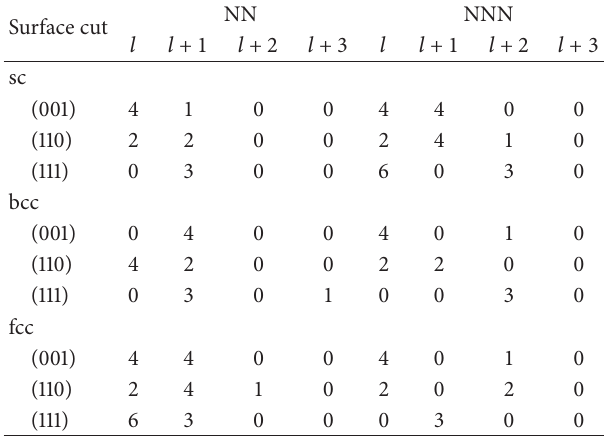
Table 1: The numbers of nearest neighbors (NN) and next nearest (NNN) neighbors in adjacent lattice planes parallel to the surface in cubic thin films and three surface cuts. Individual planes are numbered 𝑙 ± 𝑛 , where 𝑛 = 0,...,3 for considered